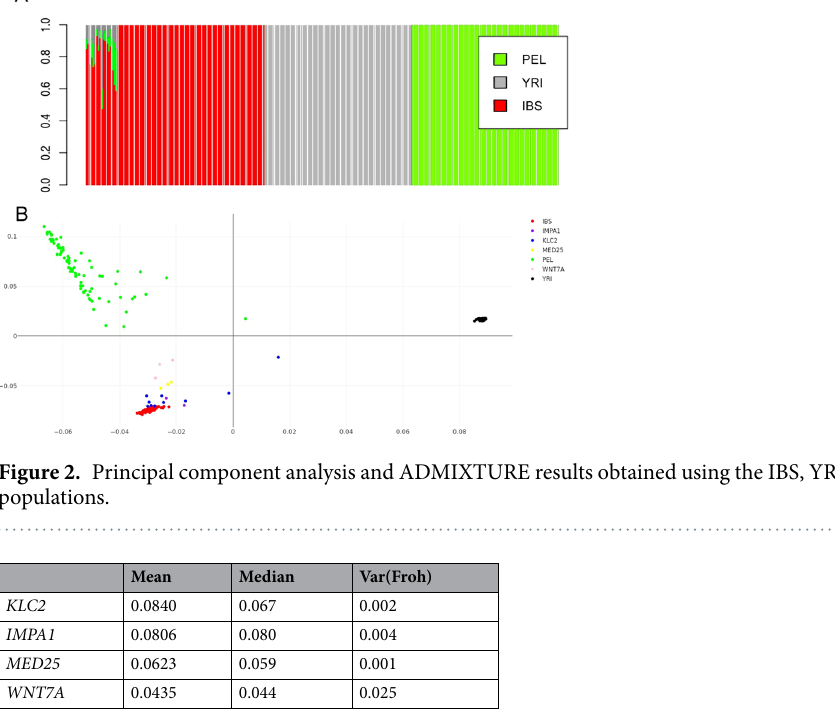
Table 2. Mean, median and variation of Froh estimated for each disease, considering ROH above 1.5